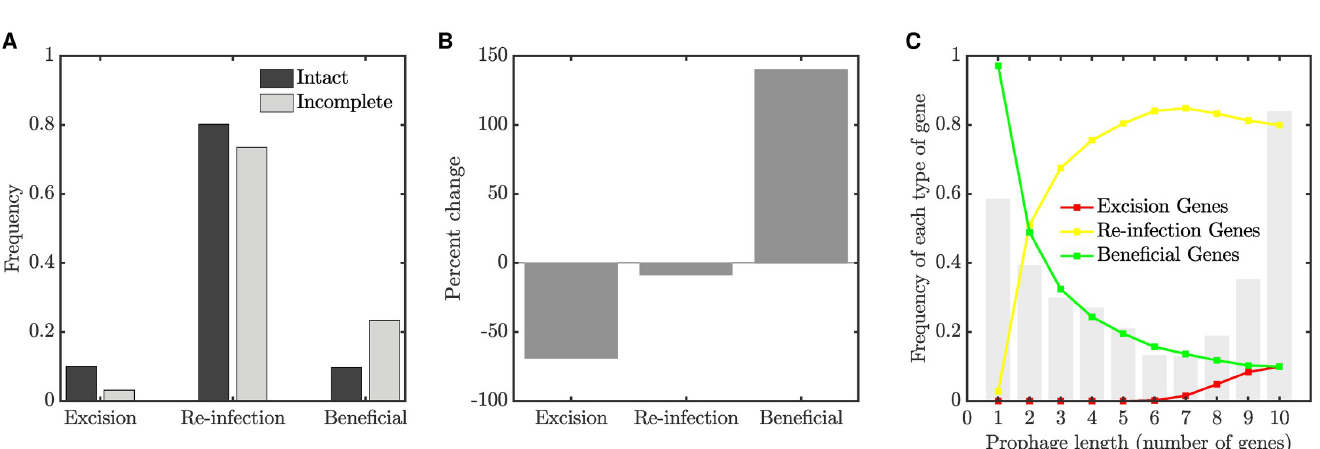
Fig 5. Gene frequencies in intact and incomplete prophages. (A) Frequency of genes of each type in intact and incomplete prophages, for the computational model simulated at the persistence equilibrium (see text for details). (B) Percent change in gene frequency from intact to incomplete. (C) A histogram of prophage lengths (grey bars), as well as the frequency of gene classes at each length. We find a bimodal distribution of prophage sizes, with smaller prophages losing the excision and re- infection genes but retaining the beneficial gene. A population of 10,000 prophages was simulated for 20,000 generations.